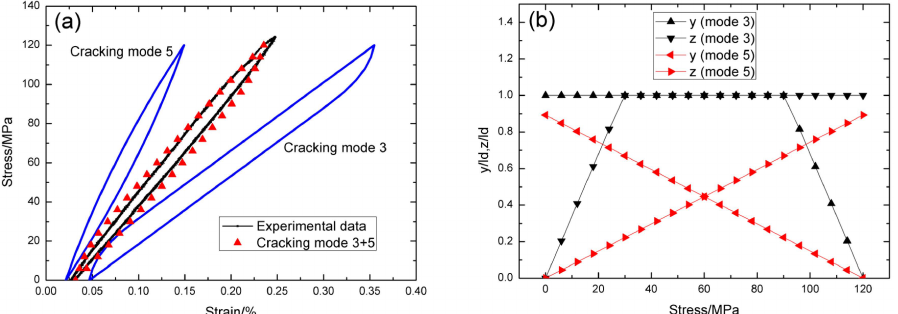
Figure 6. ( a ) The theoretical and experimental hysteresis loops; and ( b ) the interface slip lengths, i.e. , y / l d and z / l d , of matrix cracking mode 3 and mode 5 of cross-ply C/SiC composite when σ max = 120